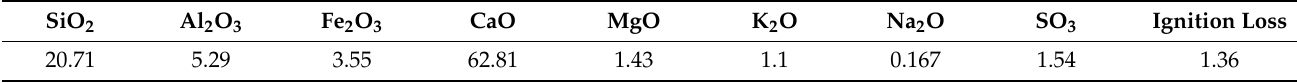
Table 1. The oxide compositions of the cement